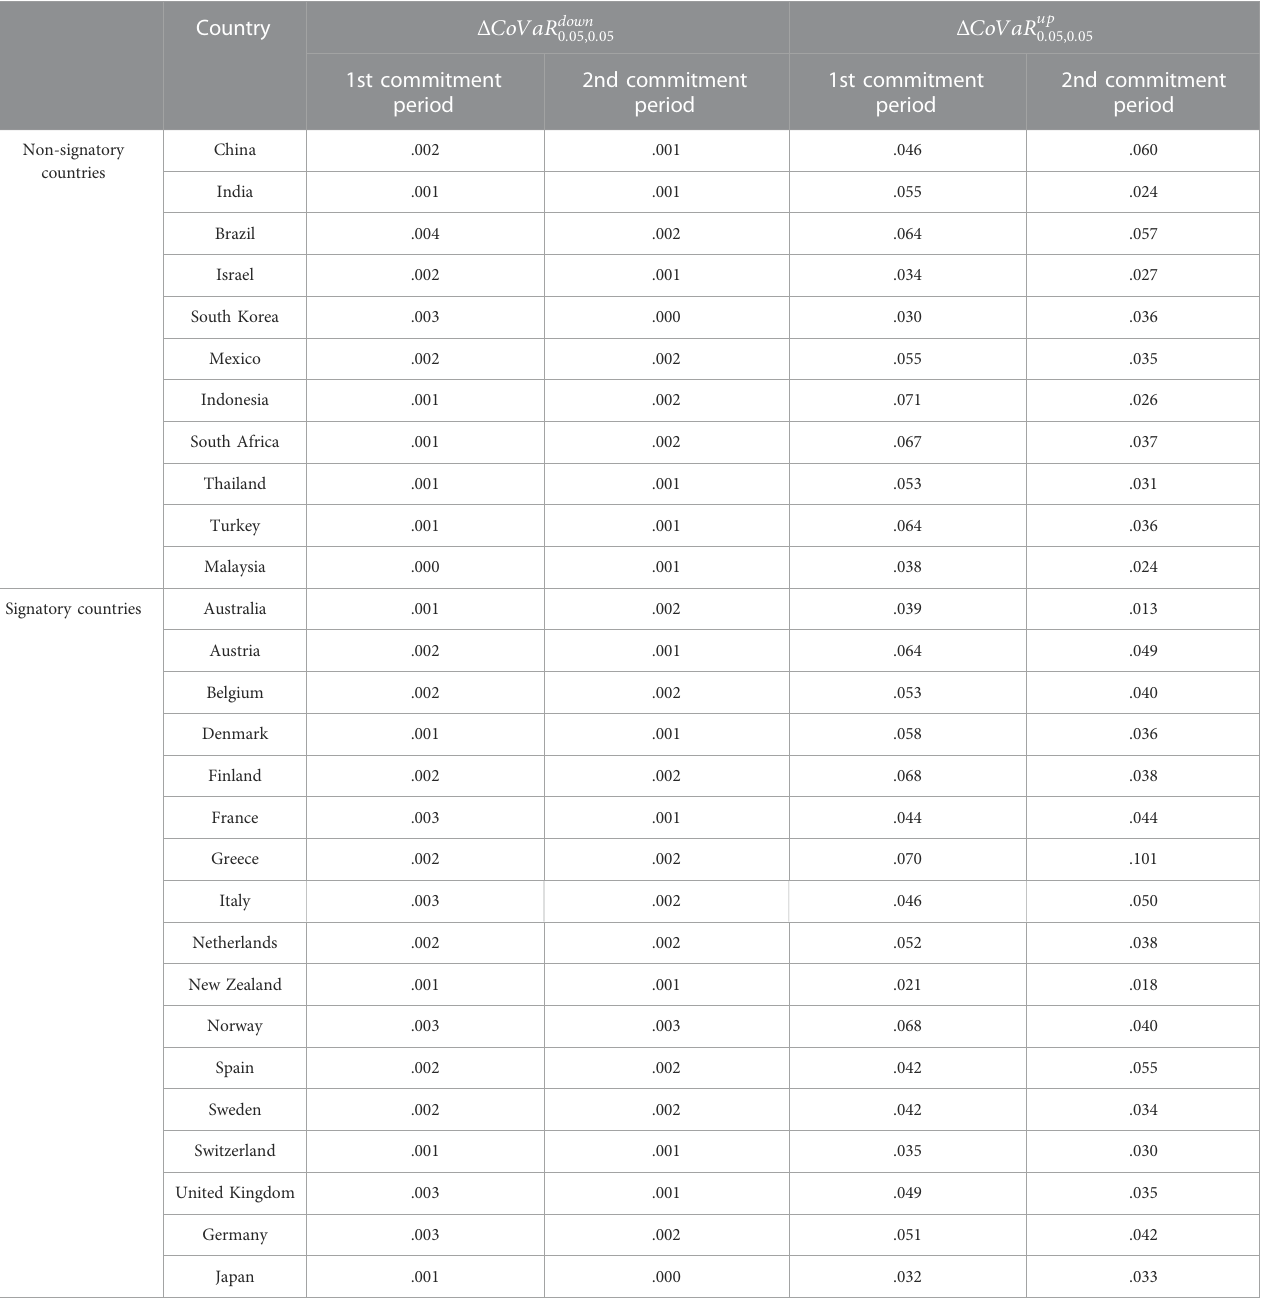
TABLE 5 Risk spillover effects indicated by Δ CoVa R